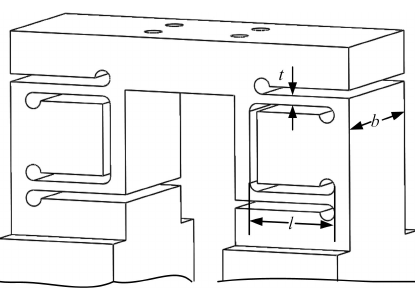
Figure 6. Double linear spring prismatic joint.